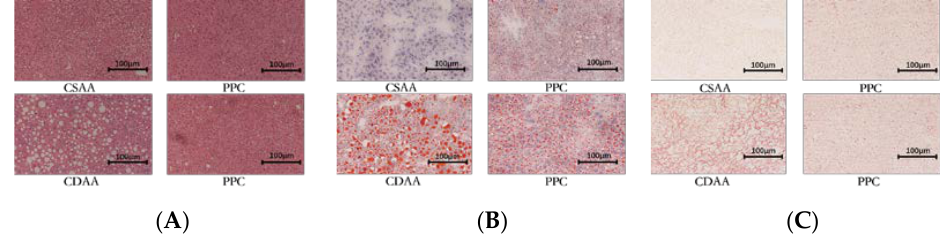
Figure 2. Section with hematoxylin and eosin staining ( A ), section with oil red O staining ( B ), and section with Sirius red staining ( C ) of the mouse liver tissue at 100× magnification. Table 1. NAS score of the CDAA, CSAA, and PPC groups. NAS Average Score Variance CSAA 1.44 0.60 3.78 0.97 2.56